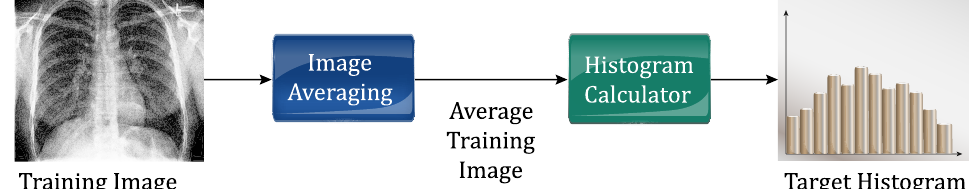
Figure 5. Target evaluation under the alternative histogram-based